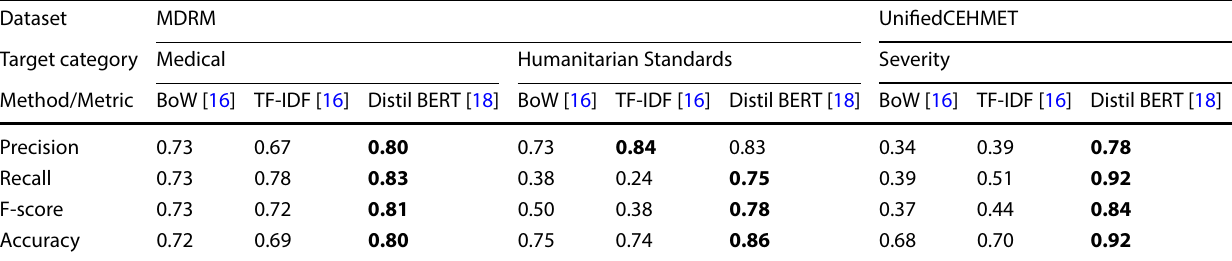
Table 5 Comparison of binary classification on mdrm and unifiedcehmet datasets for the disaster categories medical, humanitarian stand- ards, and severity